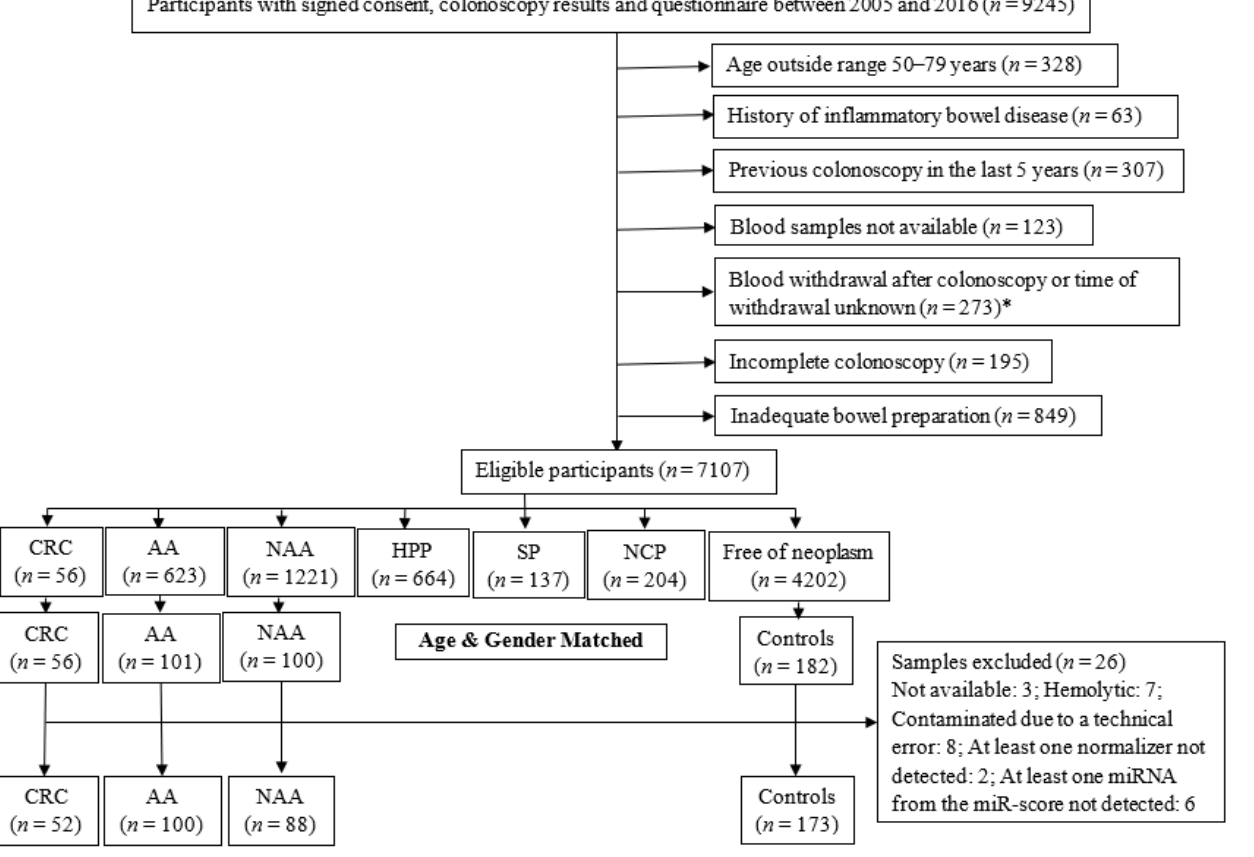
Figure 1. Flow diagram for selection of participants. AA, advanced colorectal adenoma; CRC, colorectal cancer; HPP, hyperplastic polyp; NAA, non-advanced colorectal adenoma; NCP, non-classified polyp; SP, serrated poly. *: The exclusion criteria for selection of CRC cases were not applicable after this point.